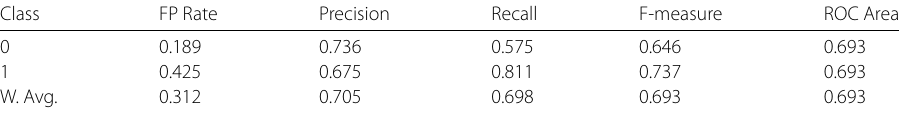
Table 5 Training accuracy per class for the region of interest estimation, using 5-fold cross validation Class FP Rate Precision Recall F-measure ROC Area